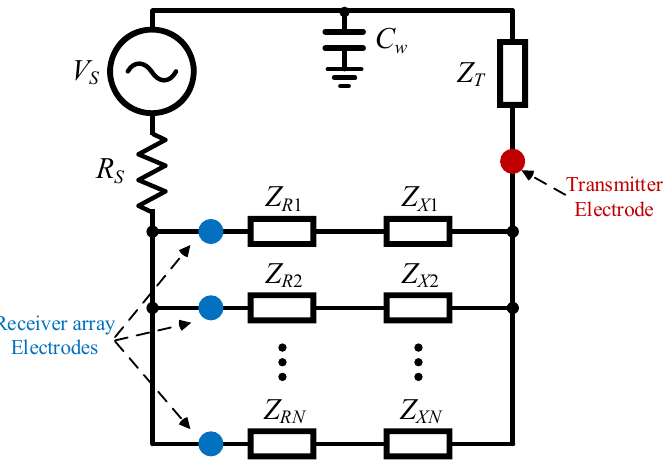
Figure 1. The circuit model of UMMAI imaging